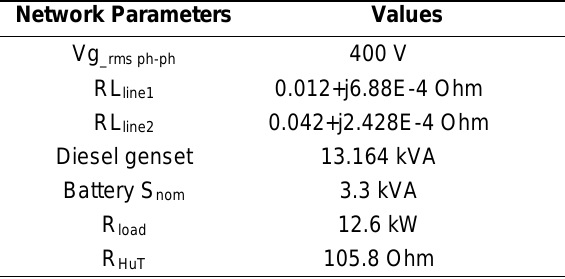
Table 2. Diesel generator parameters